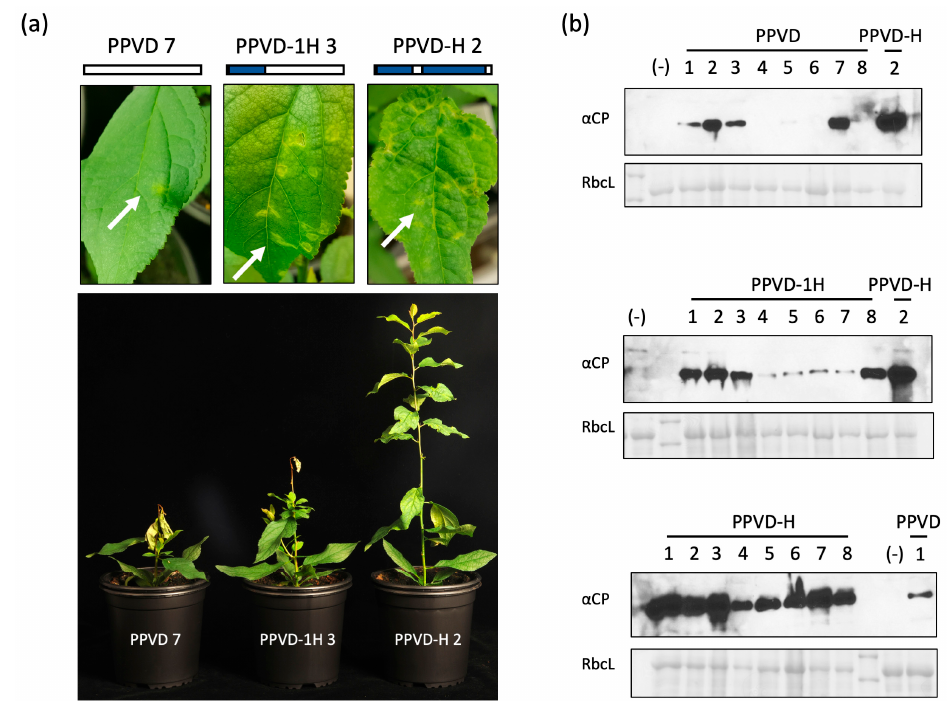
Figure 2. Testing of PPVD, PPVD-1H and PPVD-H in ‘Docera 6 (cid:48) resistant plants. ( a ) Images were taken at 14 dpi (upper part) from leaves showing different symptoms depending on the inoculated virus; number following the viral name indicates the number of the plant; small scheme of the viral constructs is depicted: PPVD and PPVD-H sequences are shown in white and in blue, respectively; white arrows mark the observed symptoms; the image in the lower part was taken at 25 dpi. ( b ) Anti-CP immunoblots of protein extracts from tissue collected at 21 dpi from upper non-inoculated leaves of the different plants; the numbers on top of each lane correspond to the number of the plant; a sample from PPVD-H or PPVD was loaded in each gel as control; negative control, marked with ( − ), corresponds to a healthy ‘Docera 6 (cid:48) plant; a Ponceau red-stained blot (RbcL) is shown below each membrane as loading